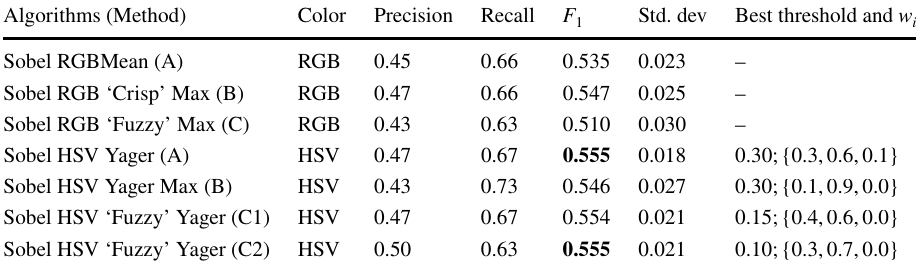
Table 1 Sobel evaluated measures for HSV and RGB algorithms (average of 10 cross- validation sets)—closest human